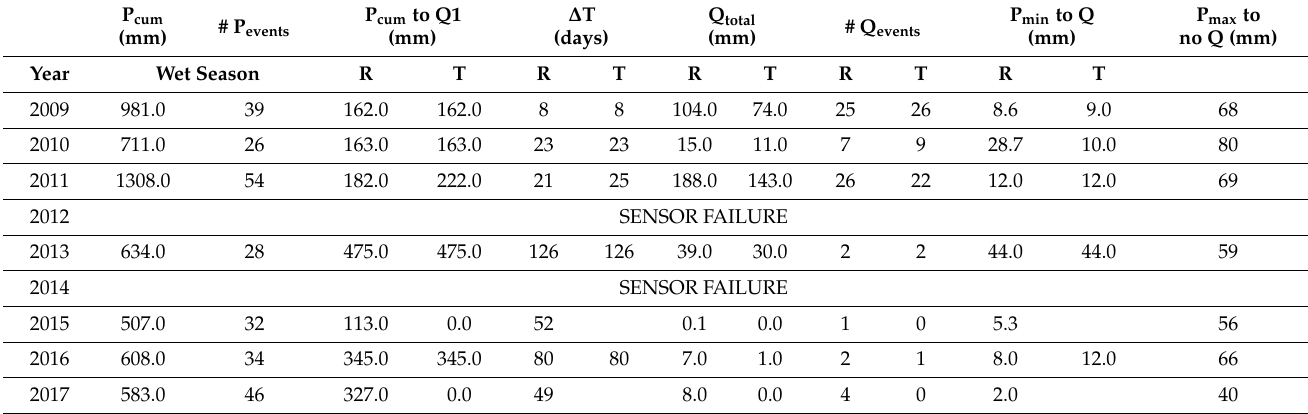
Table 4. Rainfall characteristics: rainfall runoff data set (2009–2017).